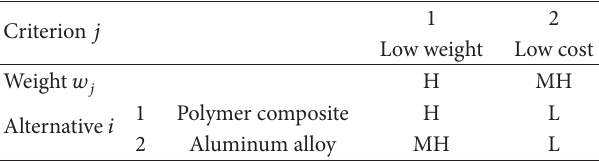
Table 1: Linguistic weights of the criteria and ratings of the alternative materials. Criterion 𝑗